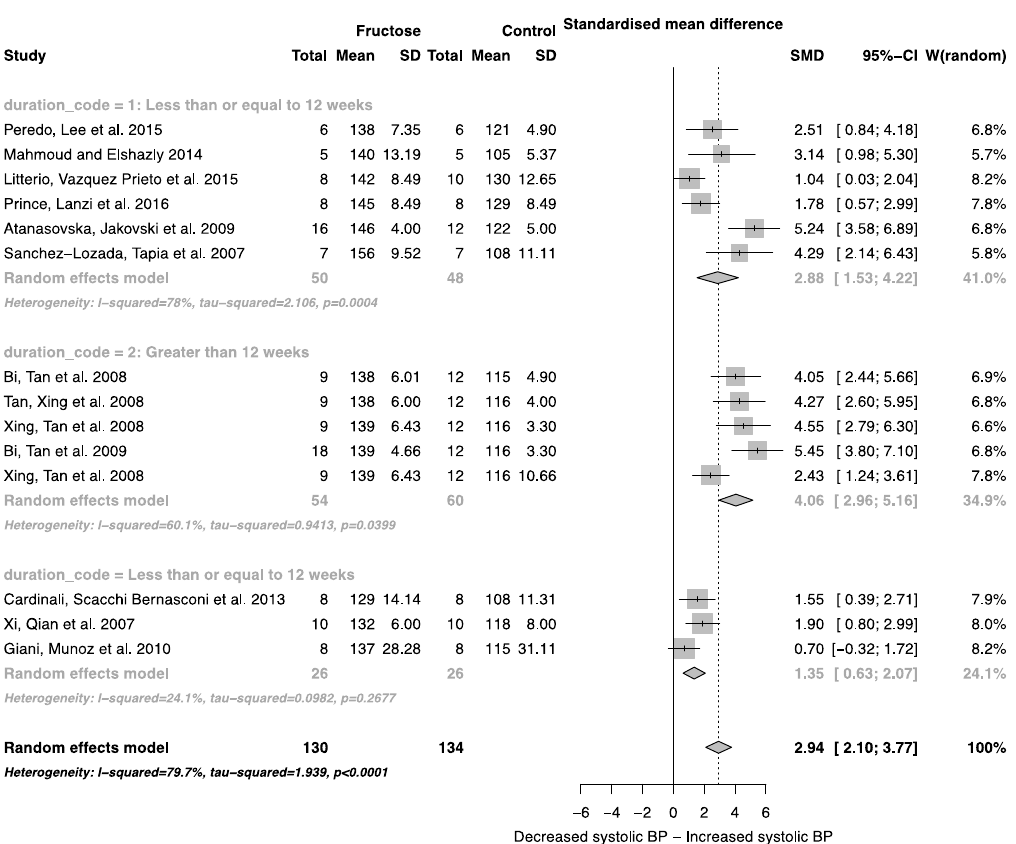
Figure 3. Forest plots of the effect of fructose consumption on adult male systolic blood pressure (mean and standard deviation (SD)), split by study duration. The pooled effects estimates are represented by three diamonds; one for studies of 12 weeks or less, one for studies of greater than 12 weeks, and one representing the combined effect. Data are presented as standardized mean differences (SMD) with 95% confidence interval (CI). p -Values are for the inverse variance random effects models with DerSimonian-Laird estimator for Tau 2 . Inter-study heterogeneity was tested by Cochran’s Q at a significance of p < 0.10 and quantified by I 2 .